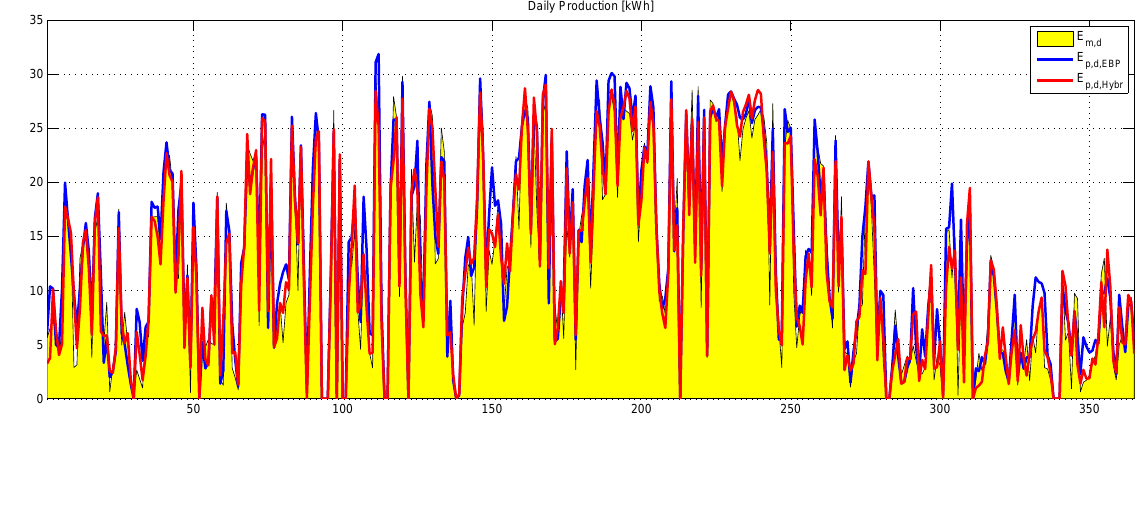
Figure 6. Daily absolute error e